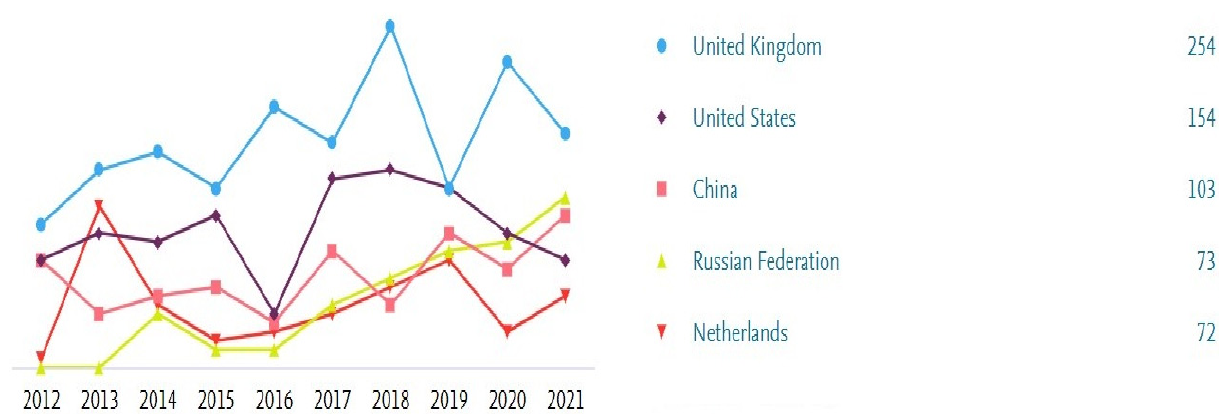
Figure 5. Five most active countries.